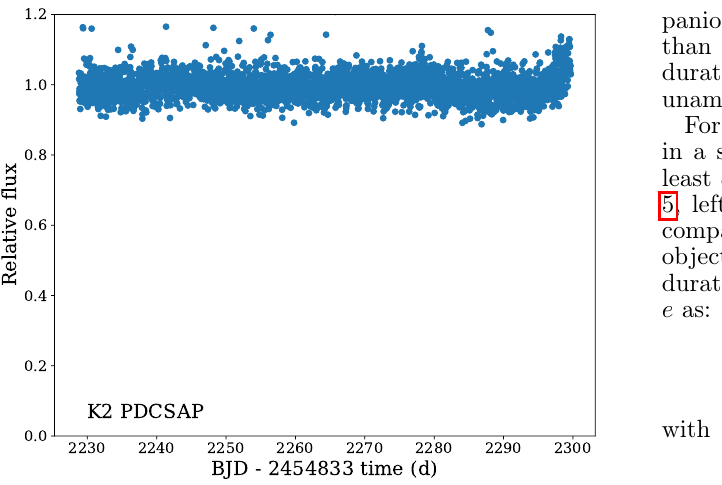
Fig. 3.— K2 lightcurve for Roque 12. Shown are the relative fluxes from the PDCSAP